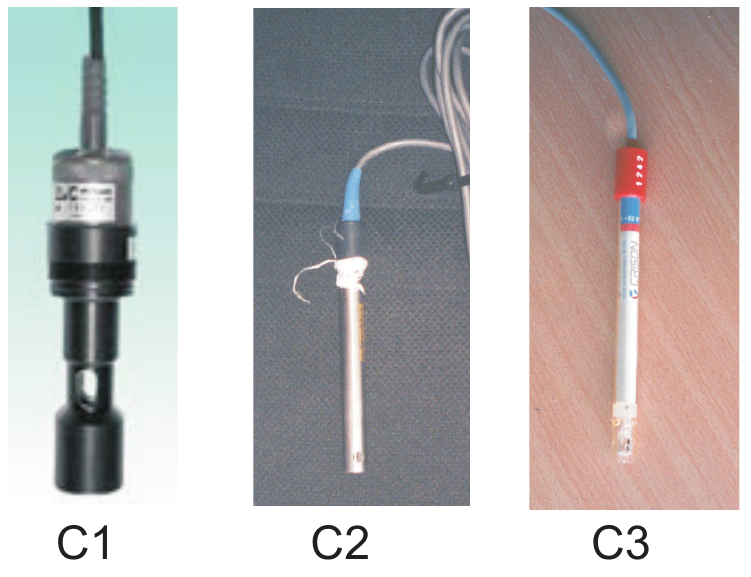
Figure 3. Commercial probes used on experiments.